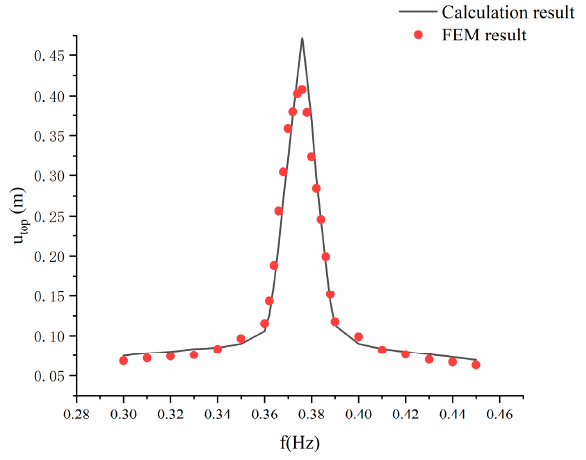
Figure 9. Comparison between the calculation result and FEM result.